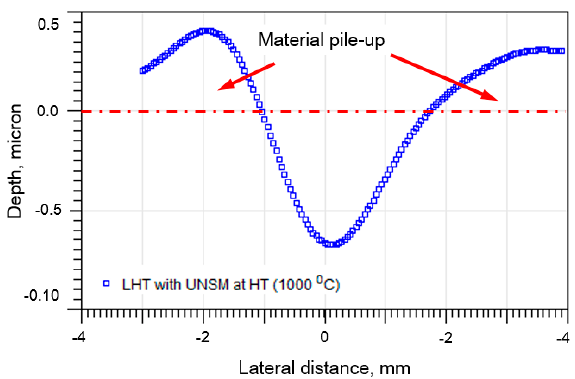
Figure 8. Cross-sectional profile of the residual indent on the surface of the UNSM-treated at RT specimen.